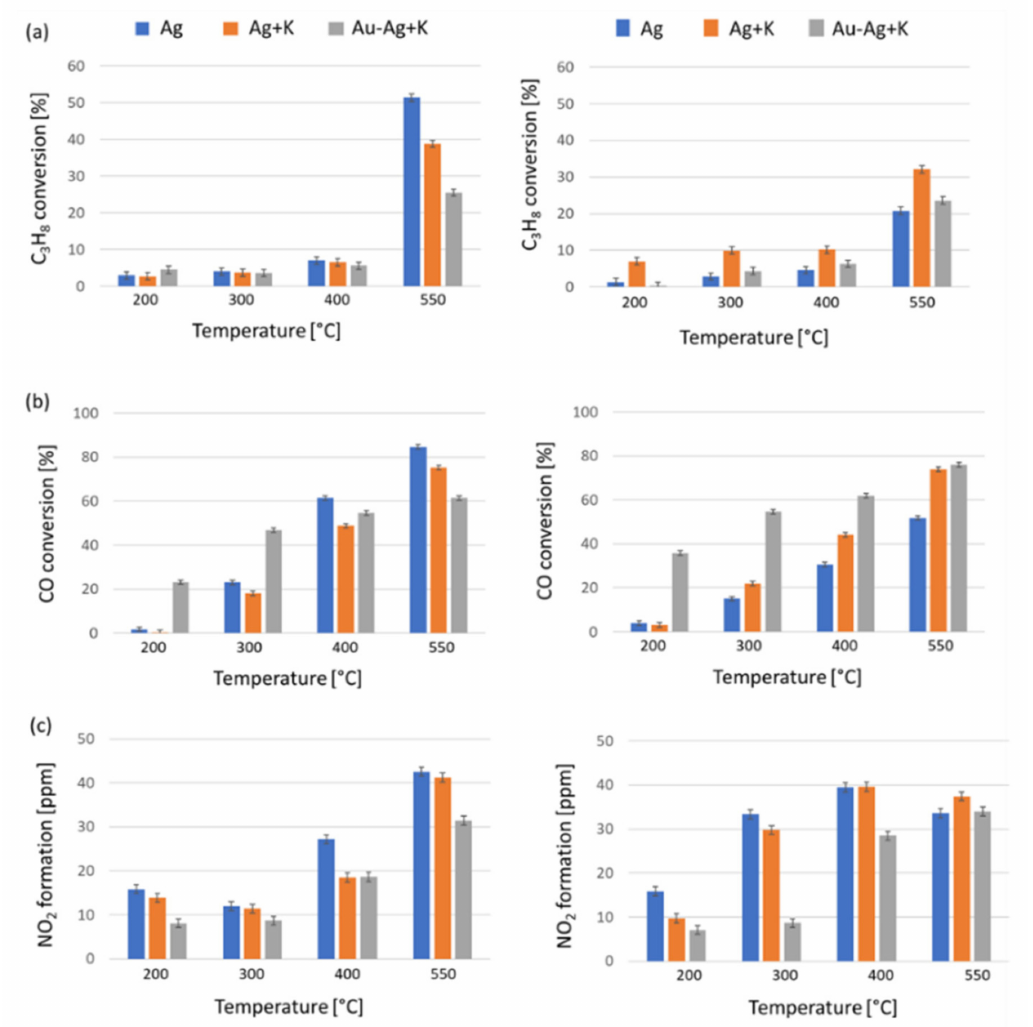
Figure 8. Activity results for Ag/CZ, Ag+K/CZ, and AuAg+K/CZ in complex stream: ( a ) C 3 H 8 combustion, ( b ) CO oxidation, and ( c ) NO 2 formation without (left) and with water vapor (right) in the inlet